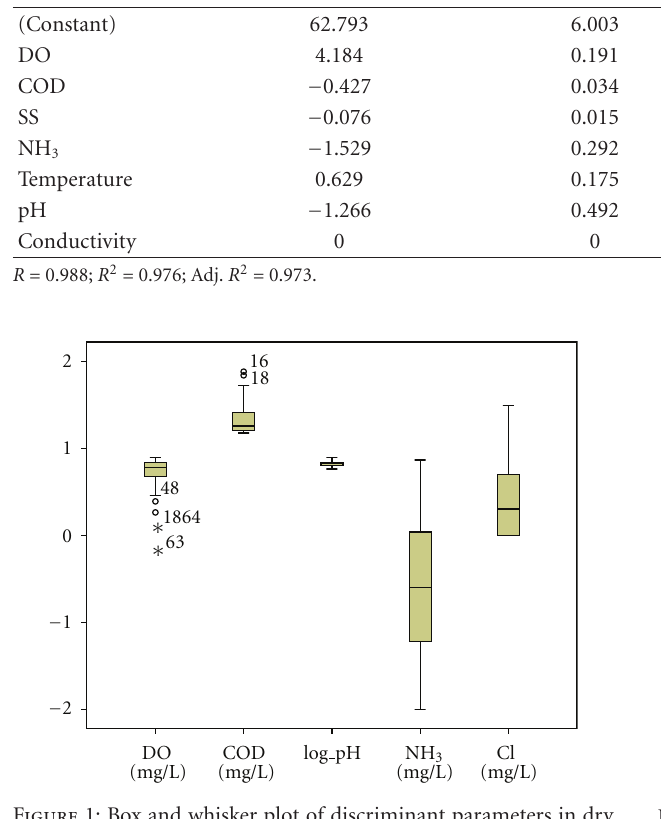
Figure 1: Box and whisker plot of discriminant parameters in dry season (forward and backward stepwise).